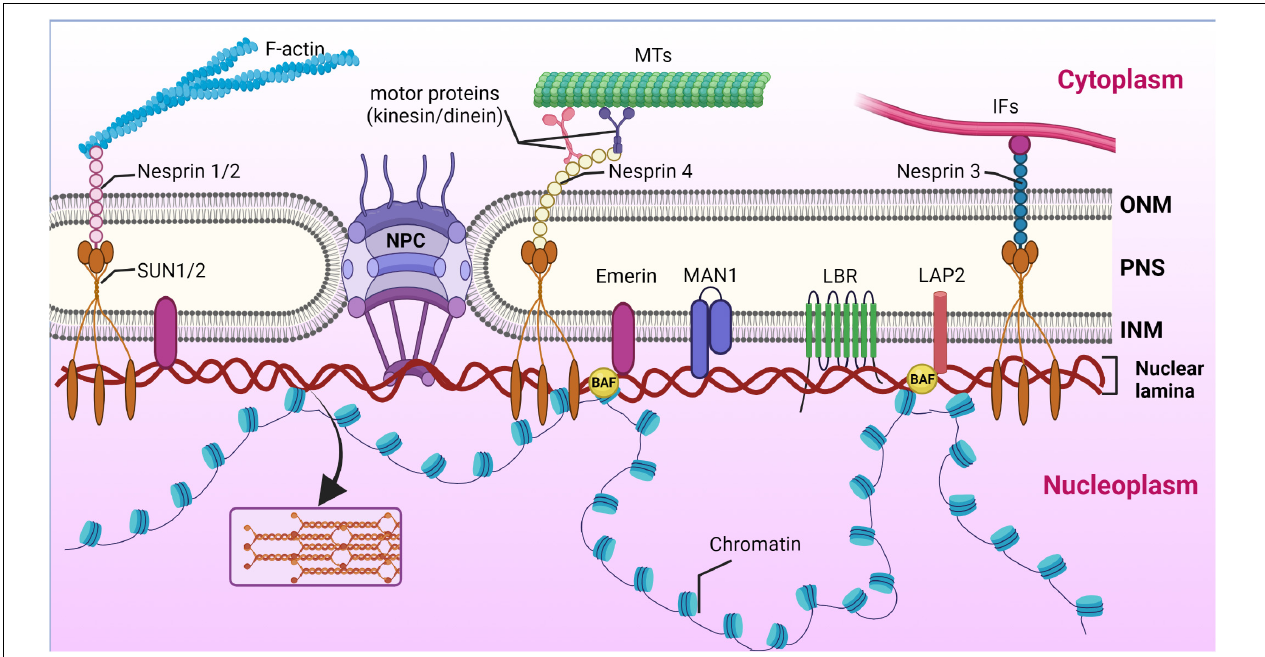
FIGURE 5 | Cooperation of nuclear lamina with nuclear envelope proteins and chromatin. Nuclear lamina is localized between the inner nuclear membrane (INM) and chromatin. Schematic representation of lamin interaction with inner nuclear membrane proteins, the most important of which are MAN1, LAP2, SUN1/2, Emerin, and LBR. The nuclear pore complex (NPC) spans both the inner nuclear membrane (INM) and the outer nuclear membrane (ONM) and mediates macromolecular transport. Via SUN1/2 and the nesprins interacting with them, located in the ONM, lamins cooperate with cytoskeleton components, namely filamentous actin (F-actin), microtubules (MTs), and intermediate filaments (IFs). The space between the ONM and INM is termed the perinuclear space (PNS). Created with BioRender.com.